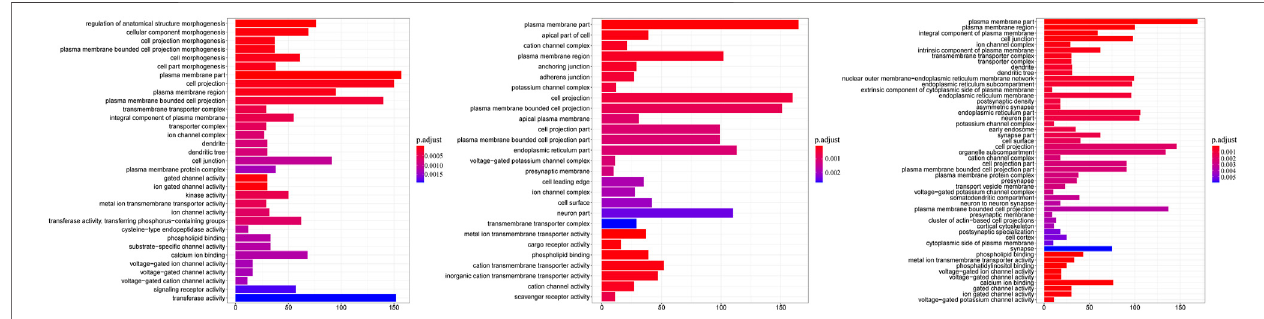
FIGURE 3 | Gene ontology categories enriched for DMGs. The y -axis is the name of GO terms; the x -axis is the gene number in terms. CC: clinical cow; SC: subclinical cow; and HC: healthy cow.